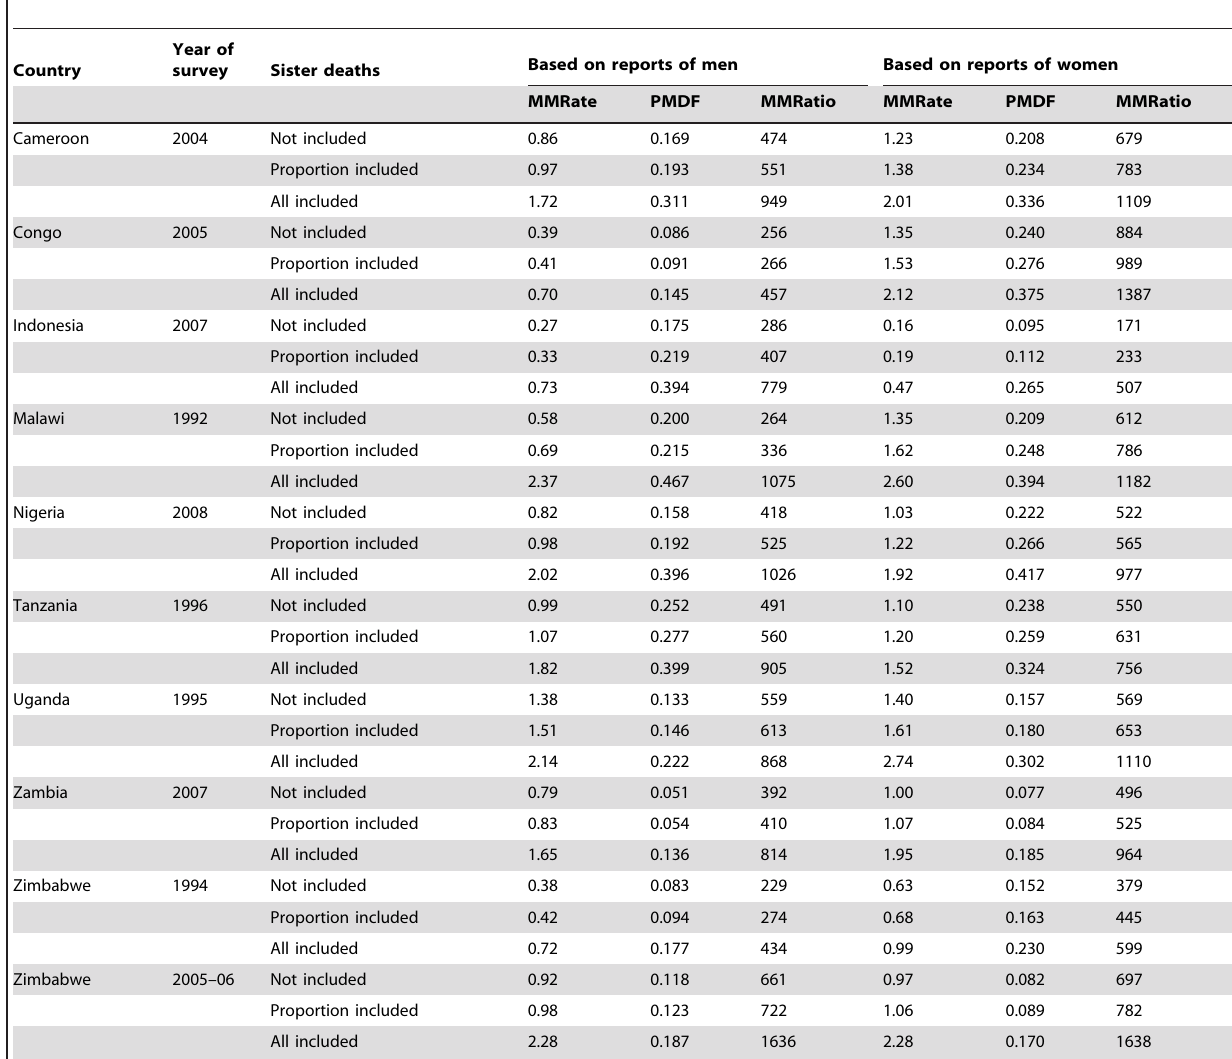
Table 4. Sensitivity analysis for maternal mortality estimates (maternal mortality rate (MMRate), proportion of maternal deaths among deaths of females of reproductive age (PMDF) and maternal mortality ratio